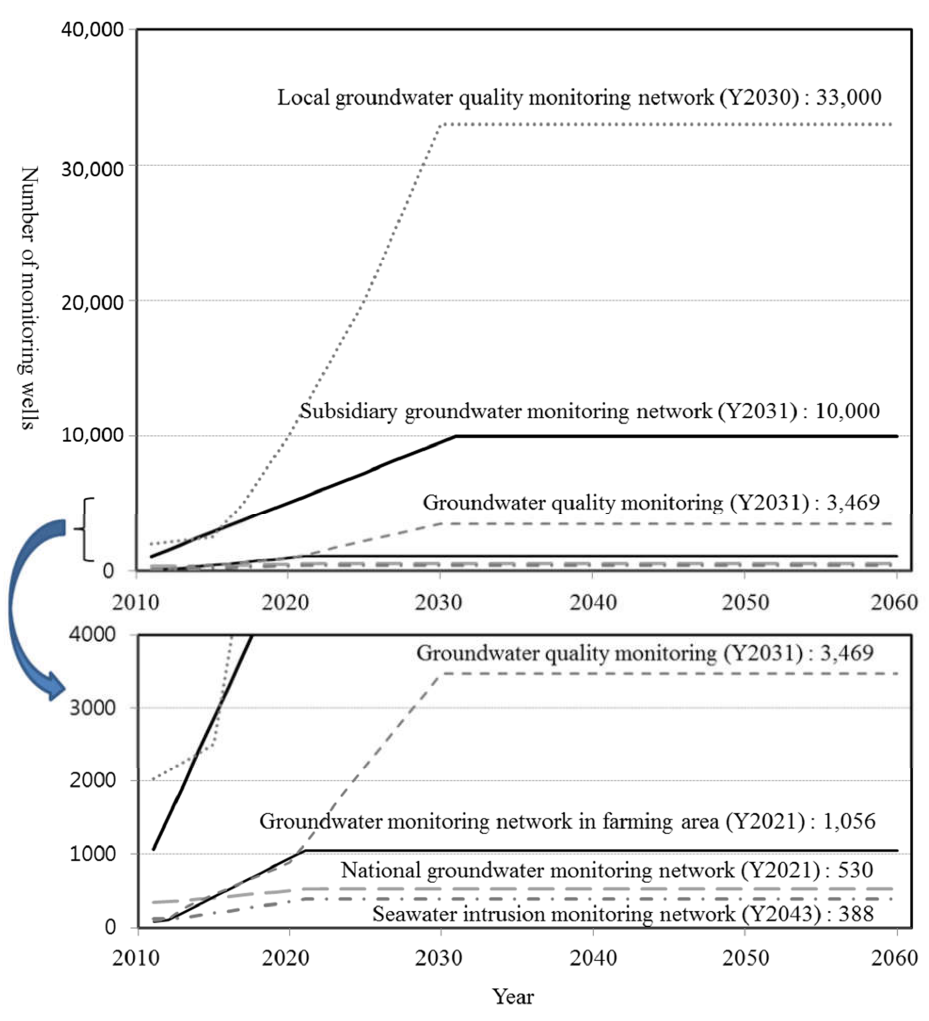
Figure 1. Current groundwater monitoring networks and future plans in South Korea. Source: Ministry of Land, Infrastructure and Transport [8]. Note: (1) The sum of the GQMN and the GPMN is displayed as the GQM. (2) This figure is drawn by the